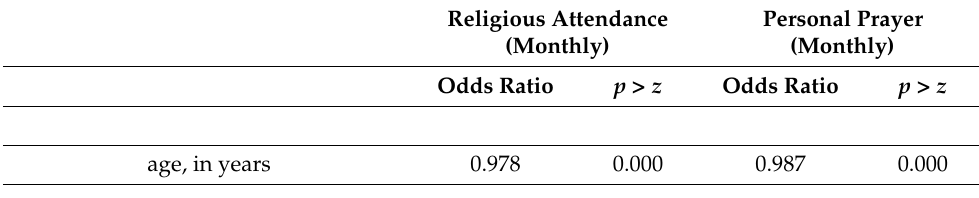
Table 4. Religious attendance and personal prayer—GEE logistic regression